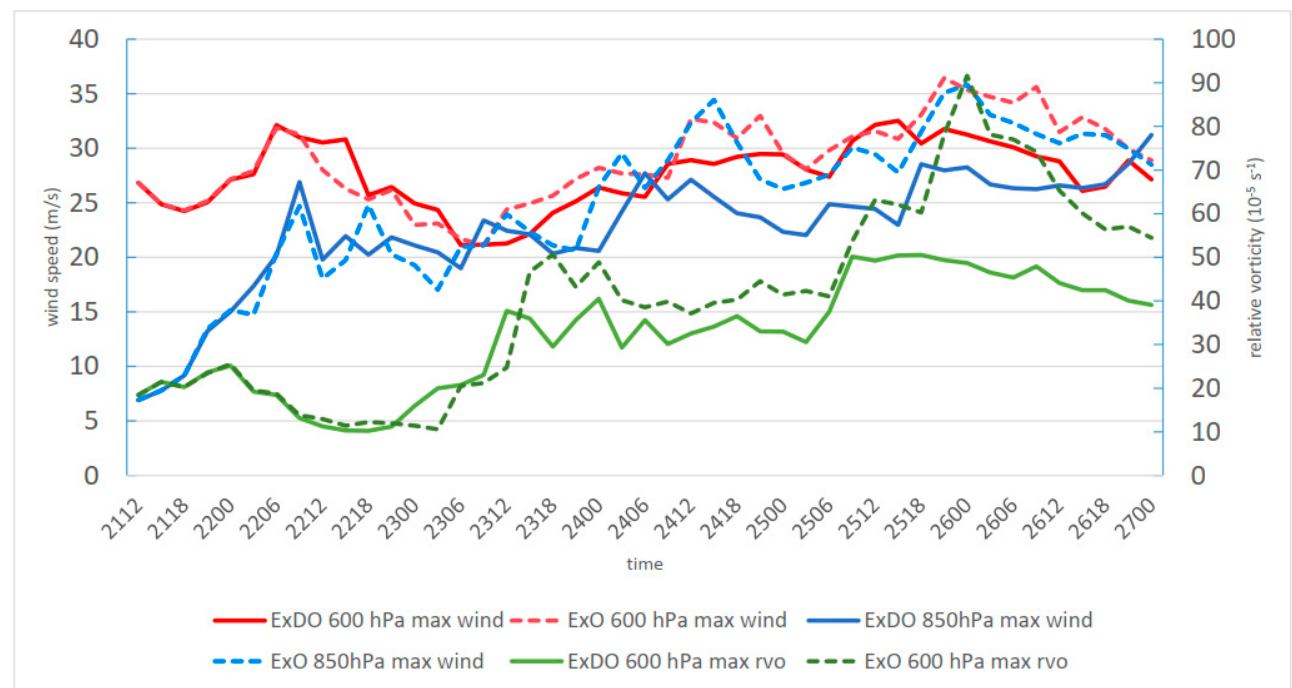
Figure 13. Time series of the maximum wind speed (m/s) at 600 hPa and 850 hPa, and the maximum relative vorticity (10 − 5 s − 1 ) at 600 hPa from ExDO and ExO. The Y -axis on the left indicates the wind speed, and the Y -axis on the right indicates the relative vorticity.